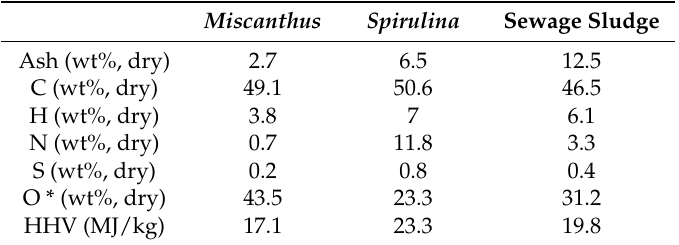
Table 1. Proximate, ultimate analysis and HHVs of the different model biomass feedstocks.